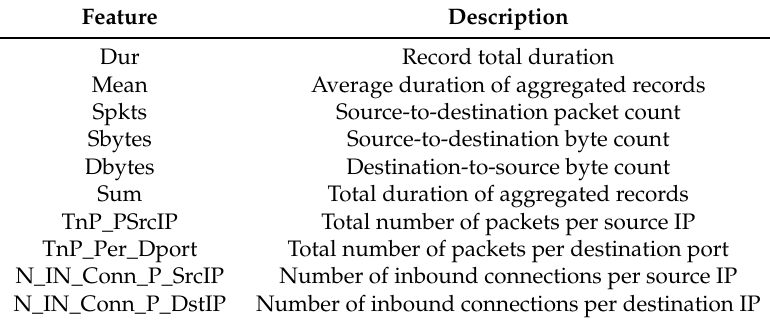
Table 6. Performance of random forest (RF) using initially selected 10